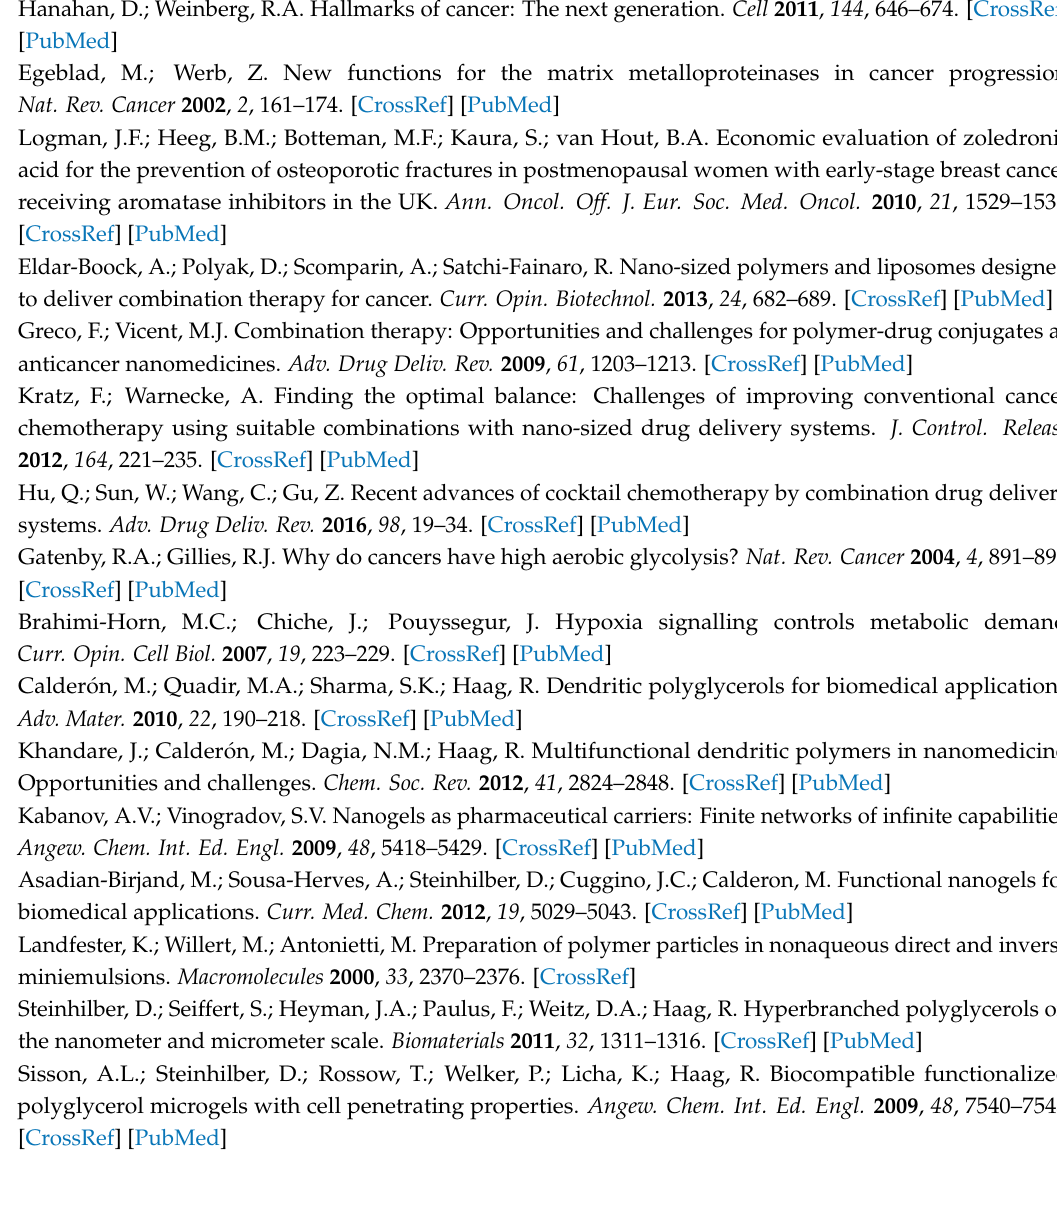
conditions, Figure S1: 1 H-NMR spectrum (DMSO- d 6 ) of macromonomer PG-PTX-SH (10%) conjugate, Figure S2: (a) Calibration curve for PTX in acetonitrile measured by RP-HPLC at a retention time of 2.85 min with acetonitrile-water (65:35) as mobile phase at a flow rate of 1.0 mL min − 1 under isocratic regime. The injection volume was 50 µ L. (b) Representative release profile of PG-PTX-DOX NG at pH 4.0 and 7.4 at 37 ◦ C over 25 h. The PTX release (%) was quantified by RP-HPLC. Mean ± SEM were obtained from triplicates in three independent experiments, Figure S3: GPC chromatogram of NG3 at 480 nm, Figure S4: Representative release profile of PG-DOX NG at pH 4.0 and 7.4 over 45 h and calculated from the fluorescence spectra (Figure 8a,b) at 592 nm. The fluorescence intensity value at 45 h was set to 100% and the value at time point 0 to 0%, Figure S5: Fluorescence emission spectra of PG-DOX-SH conjugate after incubation in (a) acetate buffer (pH 4.0, 50 mM) and (b) phosphate buffer (pH 7.4, 50 mM) at 37 ◦ C over 45